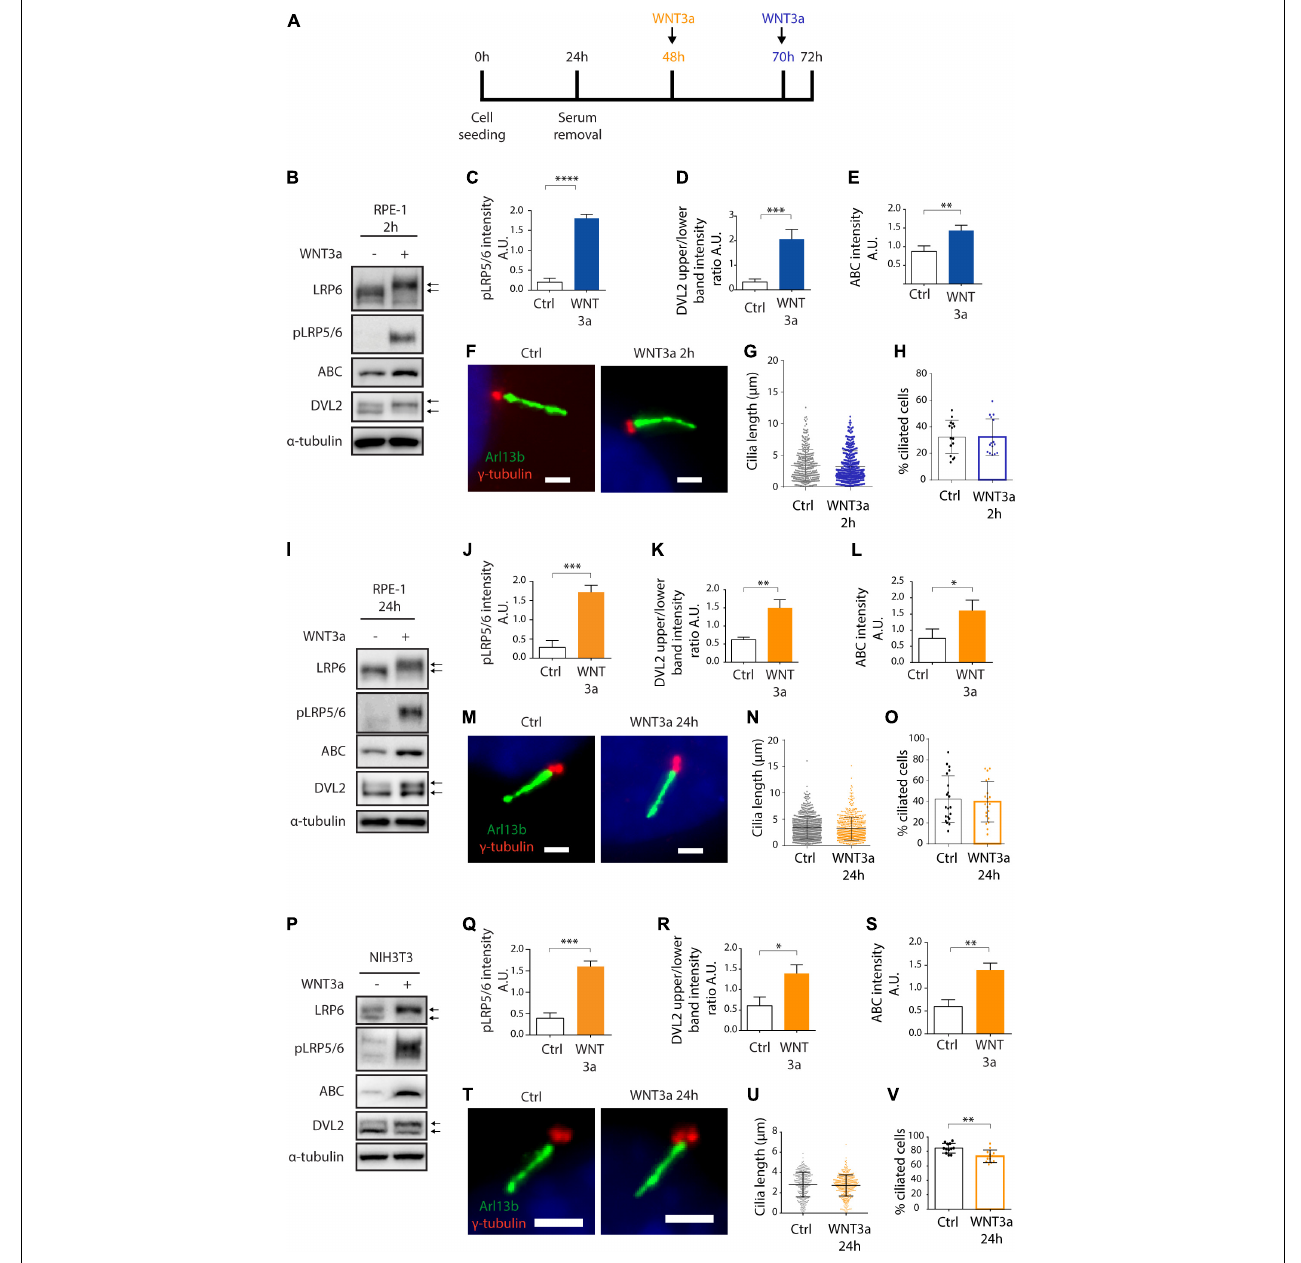
FIGURE 1 | WNT3a does not promote ciliogenesis or cilia length. (A) Experimental scheme of WNT3a treatment experiment. Cells were seeded and grown for 24 h, then starved for additional 48 h. A 2 h treatment (RPE-1) by WNT3a is indicated in blue, 24 h treatment is indicated in orange (RPE-1 and NIH3T3). (B) Western blot analysis of 2 h WNT3a treatment of RPE-1. The treatment leads to LRP6 shift and increased LRP5/6 phosphorylation, DVL2 phosphorylation and upshift, and accumulation of ABC. The quantitation of pLRP5/6 intensity is shown in (C) n = 3, DVL2 band intensities (upper to lower band intensity ratio, the bands are indicated by arrows) is shown in (D) n = 3, the quantification of relative ABC levels is presented in (E) n = 3. (F) Representative images of RPE-1 cells treated by WNT3a or vehicle (control) for 2 h and stained for Arl13b (green) and γ -tubulin (red). Scale bar = 2 µ m. DAPI (blue) was used to counter stain nuclei. The corresponding quantification of the cilia length (G) and the percentage of cells with Arl13+ cilium (H) . Each dot indicates either length of a single primary cilium (G) or percentage of ciliated cells in a single image (H) . (I) Western blot analysis of 24 h WNT3a treatment of RPE-1. The treatment leads to LRP6 shift, increased LRP5/6 phosphorylation, DVL2 phosphorylation and upshift, and accumulation of ABC. The quantification of pLRP5/6 intensity is shown in (J) n = 3, DVL2 bands (indicated by arrows) intensity ratio is shown in (K) n = 3, quantification of relative ABC levels is presented in (L) n = 3. (M) Representative images of RPE-1 cells treated by WNT3a or vehicle (control) for 24 h and stained for Arl13b (green) and γ -tubulin (red). Scale bar = 2 µ m. DAPI (blue) was used to counter stain nuclei. The corresponding quantification of the cilia length and the percentage of cells with Arl13+ cilium is shown in (N,O) , respectively. Each dot indicates either length of a single primary cilium (N) or percentage of ciliated cells in a single image (O) n = 4. (P) Western blot analysis of NIH3T3 cells treated by WNT3a for 24 h shows LRP6